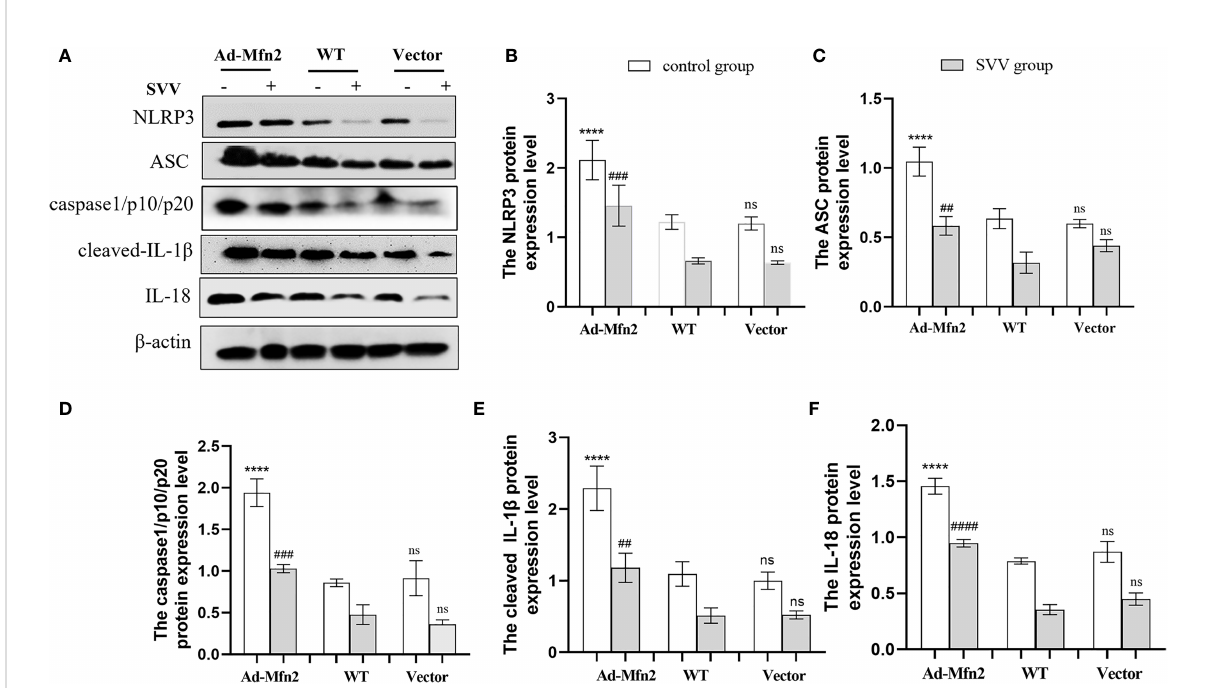
FIGURE 6 Mfn2 overexpression induced SVV-inhibited NLRP3 in fl ammasome activation in PK-15 cells. (A) The western blot assay for NLRP3, ASC, caspase1/p10/p20, cleaved-IL-1 b and IL-18. (B – F) The relative protein expression level of NLRP3, ASC, caspase1/p10/p20, cleaved-IL-1 b and IL- 18. One-way analysis of variance (ANOVA) were used to investigate the signi fi cance of differences. * means the difference between the WT and Ad-Mfn2 in control group; # means the difference between the WT and Ad-Mfn2 in SVV group; and other groups. ## ; P < 0.01, ### ; P < 0.005, **** ,#### ; P < 0.001, ns means no signi fi